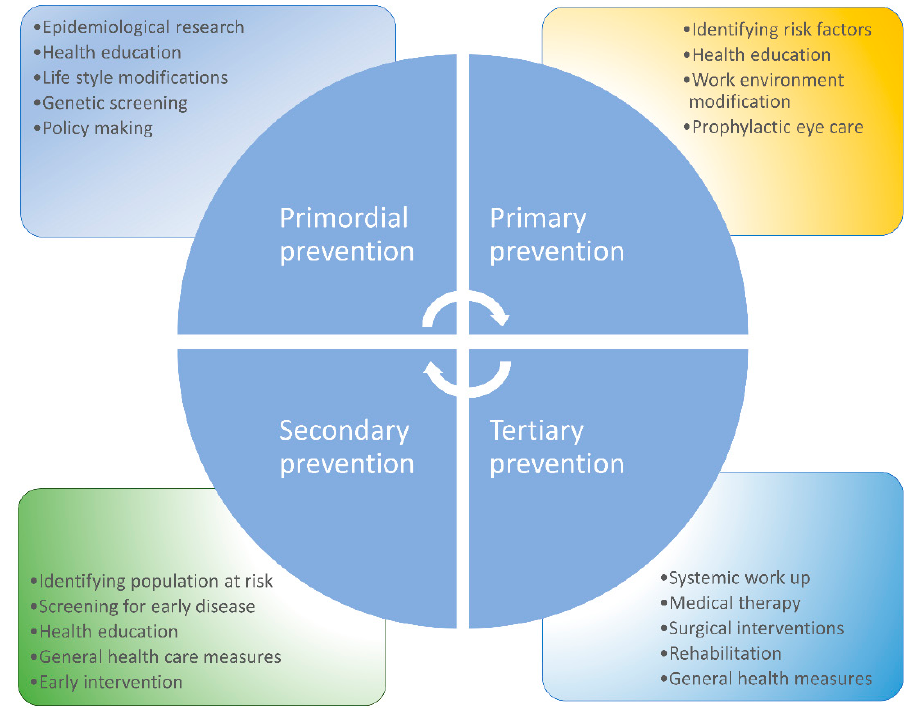
Figure 3. Summary of the various strategies for prevention of dry eye disease: this figure describes the numerous strategies for the prevention of DED at various levels of healthcare.